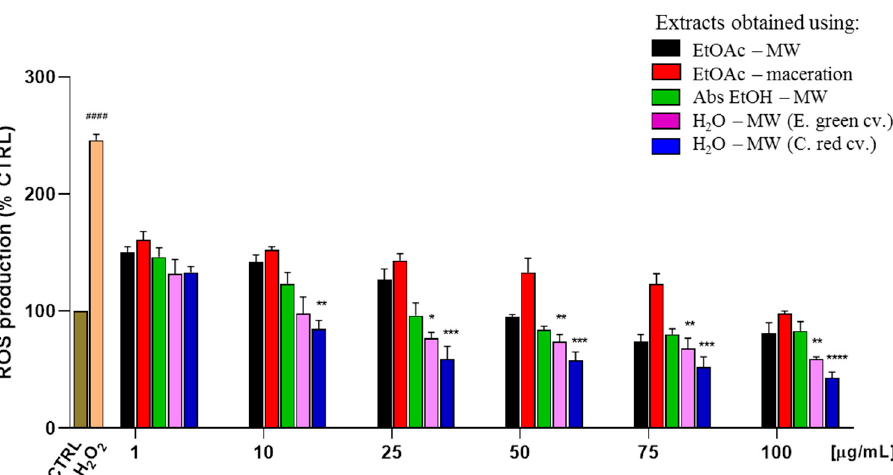
Figure 1. Antioxidant effects of extracts on intracellular ROS production by H 2 DCF-DA assay. SH- SY5Y cells were treated with different concentrations of extracts (0–100 µ g/mL) in the presence of a toxic H 2 O 2 stimulus (200 µ M). ROS production was evaluated by measuring the fluorescent intensity of control cells that were treated only with H 2 DCF (CTRL). Quercetin at 25 µ g/mL (QRC) was used as the positive control, and 89% ROS production inhibition was observed. Statistical significance was calculated using a one-way analysis of variance (ANOVA) which was followed by the Dunnett’s test (Graph Pad Prism version 5): * p < 0.1, ** p < 0.01, *** p < 0.001, **** p < 0.0001 referred to H 2 O 2 alone; #### p < 0.0001 referred to CTRL.